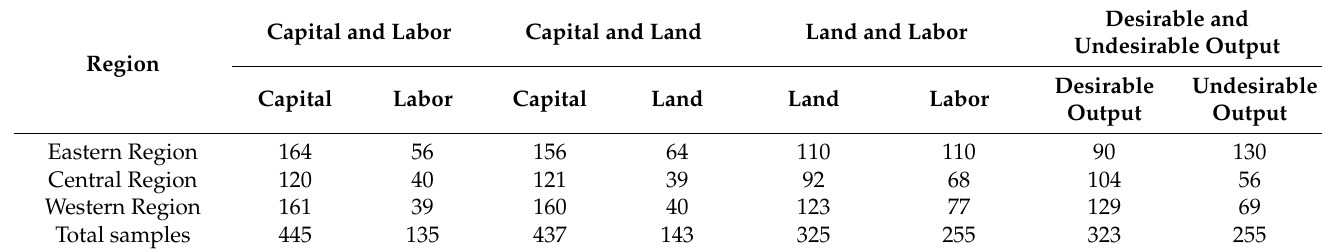
Table 5. Input bias and output bias statistics of each region.